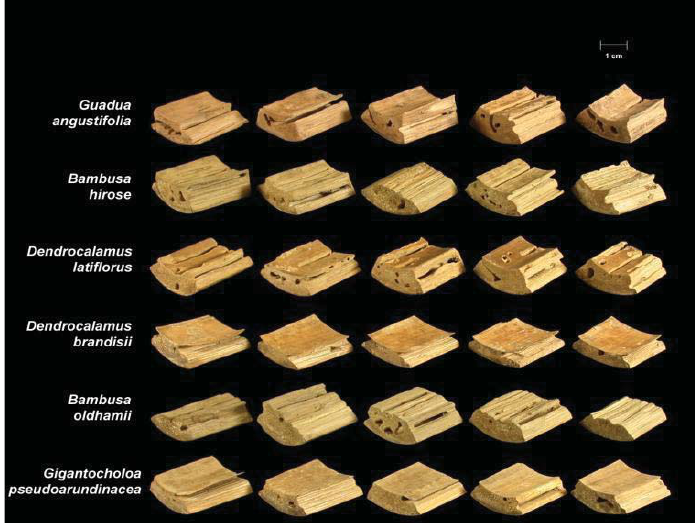
Figure 4. Bamboo blocks showing damage from C. gestroi. Image courtesy of Robert Oshiro